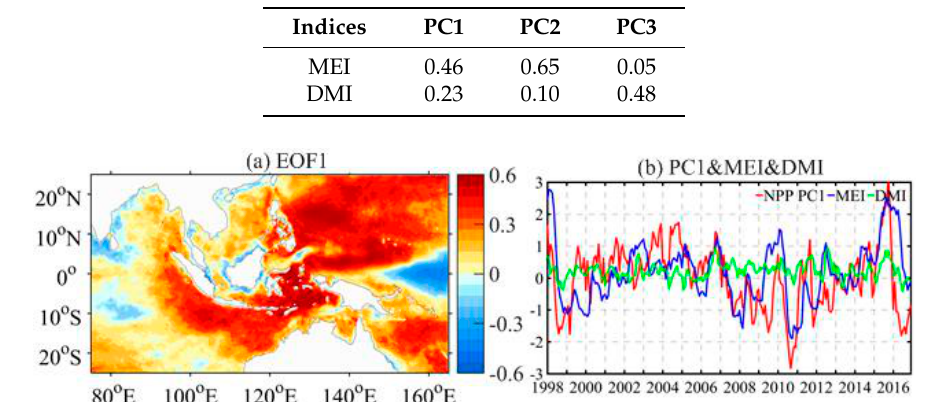
Figure 3. Interannual NPP variability characterized by the first EOF mode: ( a ) the EOF spatial pattern; ( b ) the normalized PC (red) along with MEI (blue) and DMI (green).